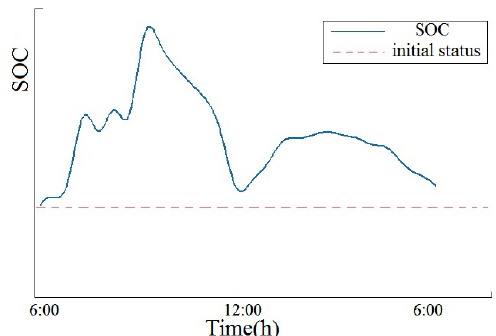
Figure 3. Initial status of the